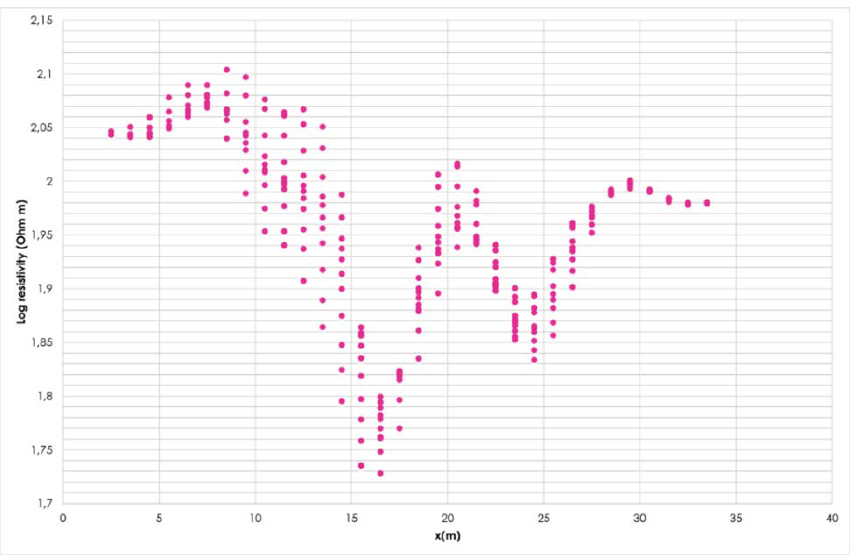
Figure 8. Example of dispersion of resistivity values at 2 m depth from all overlapping segments of Figure 6, against offset distance x along the entire profile length.